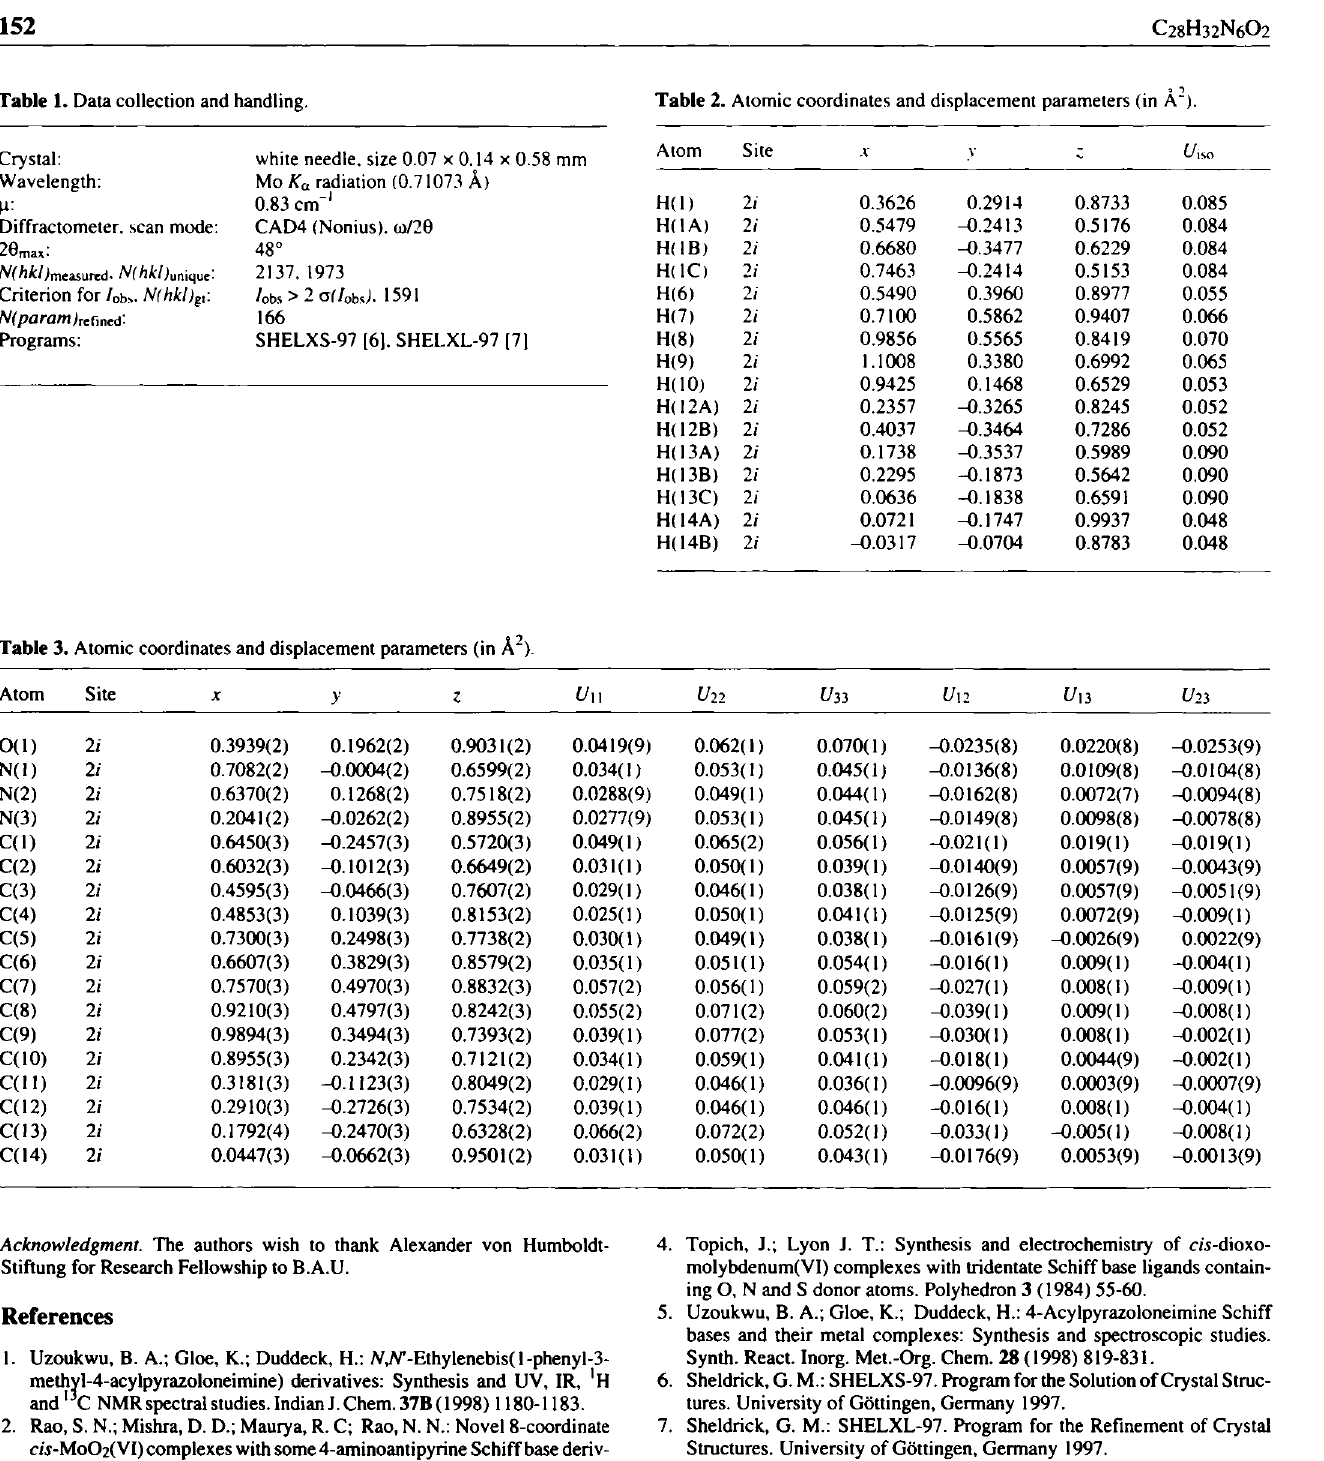
Table 1. Data collection and handling. Table 2. Atomic coordinates and displacement parameters (in A 2 ).